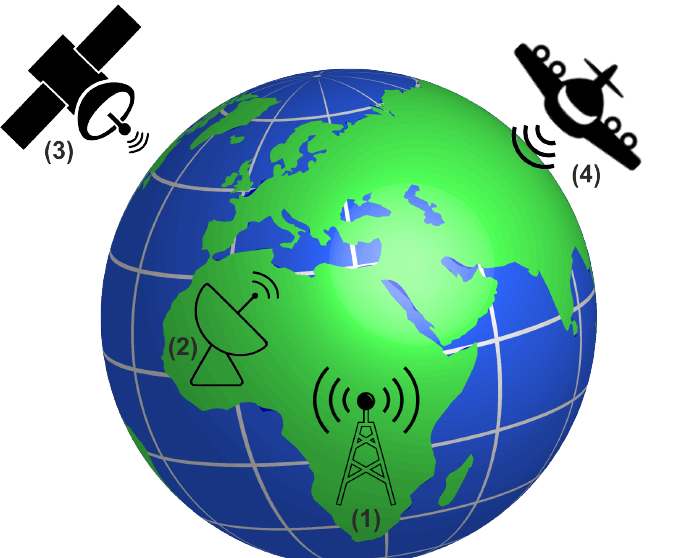
Figure 2. Example of the common RFI sources: (1) radios, (2) radars, (3) communication systems, and (4) airborne